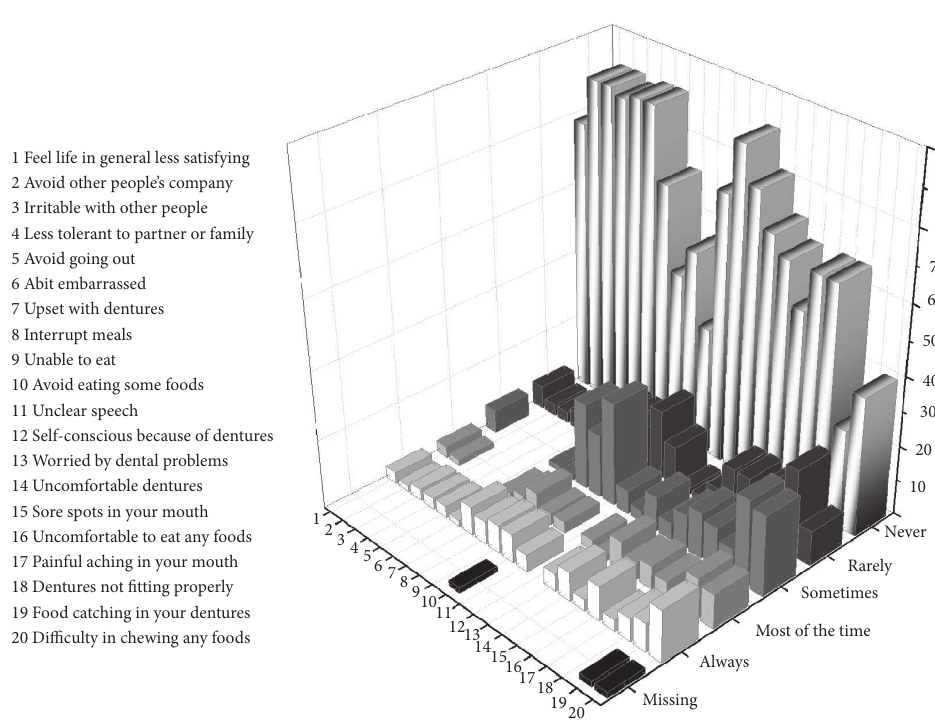
Figure 2: Percent distribution of the frequencies, for the variables assessed by the patients using the OHIP-EDENT